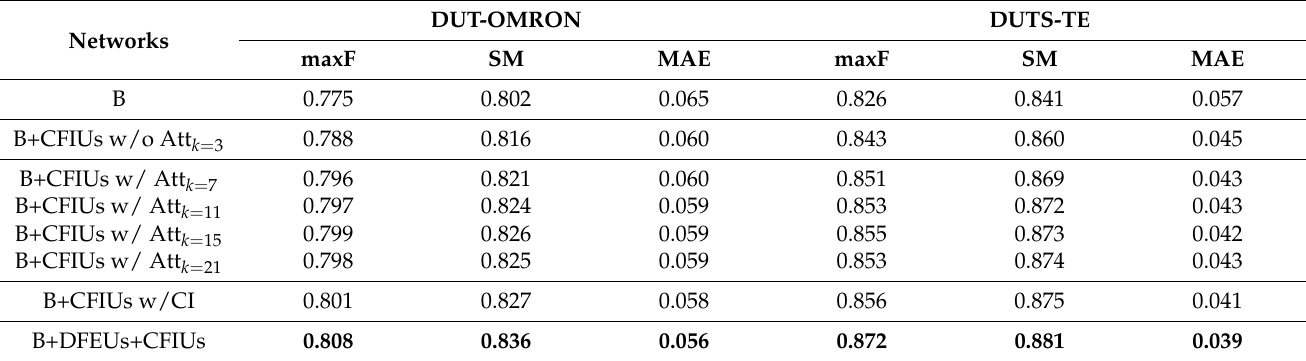
Table 4. Ablation analysis concerning the efficiency of the CFIU module. “CFIU w/o Att”, “CFIU w/ Att”, and “CFIU w/ CI” show the CFIU module without an attention mechanism, with an attention mechanism by embedding the spatial separable convolutions with large kernels instead of the standard convolution, and with CI, respectively. We observe that the performance improves as the DFEU and CFEU modules are attached. The best results are in bold.